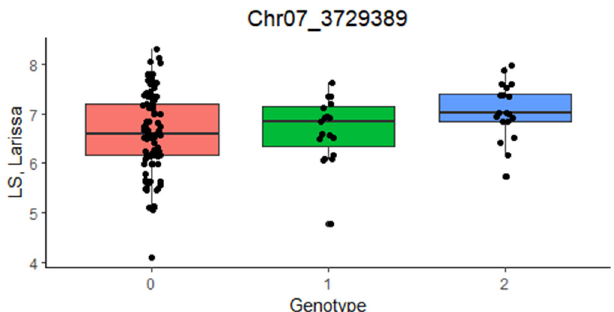
Figure 3. Boxplot showing the average value of a visual lime susceptibility (LS) score in Larissa (Greece) for the genotypic classes of the SNP Chr07_3729389, with 0 and 2 corresponding to the two homozygous classes and 1 to the heterozygous one. The thick black line represents the median, the box edges the 25th and 75th percentile, and the bar length the interquartile range.